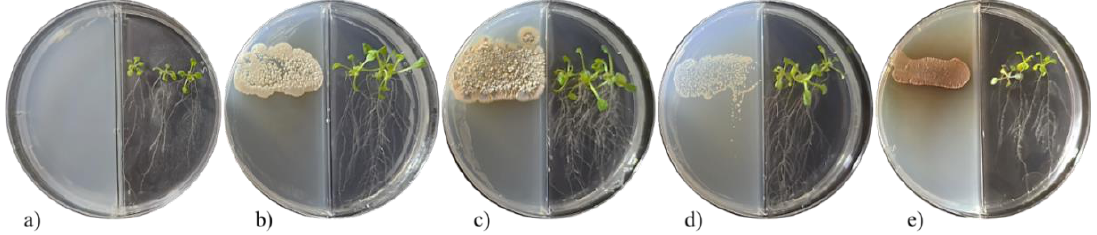
Figure 1. Appearance of A . thaliana seedlings after exposure for 10 days to VOCs emitted by Streptomyces strains. The assay was performed using divided Petri dishes; A . thaliana seeds were sown on the right, and Streptomyces strains were sown on the left of the dishes: ( a ) control; ( b ) S . cangkringensis CIAD – CA07; ( c ) S . misionensis CIAD – CA27; ( d ) S. kanamyceticus CIAD – CA45; and ( e ) S. kanamyceticus CIAD–CA48.